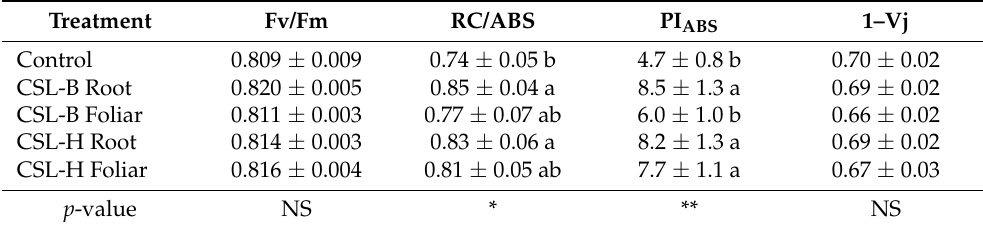
Table 3. Plant photochemical activity measured, 7 days after the last application of the treatments, as Chl a fluorescence: Fv/Fm, quantum yield of primary photosynthesis; RC/ABS, active reaction centers of photosystems; PI ABS , photosynthetic performance index; 1–Vj, electron output from photosystem